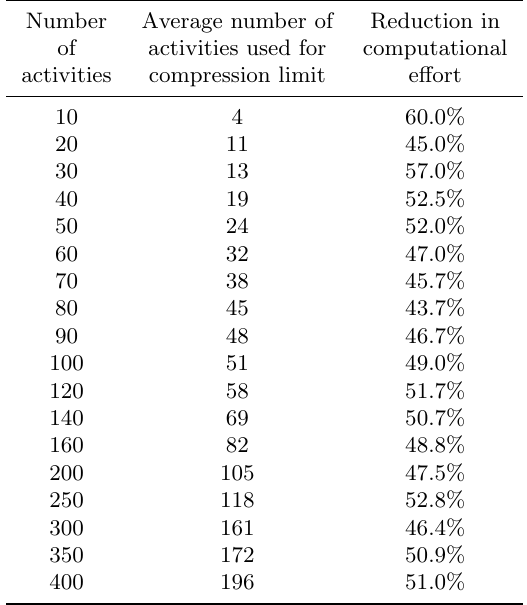
Table 6: Computational